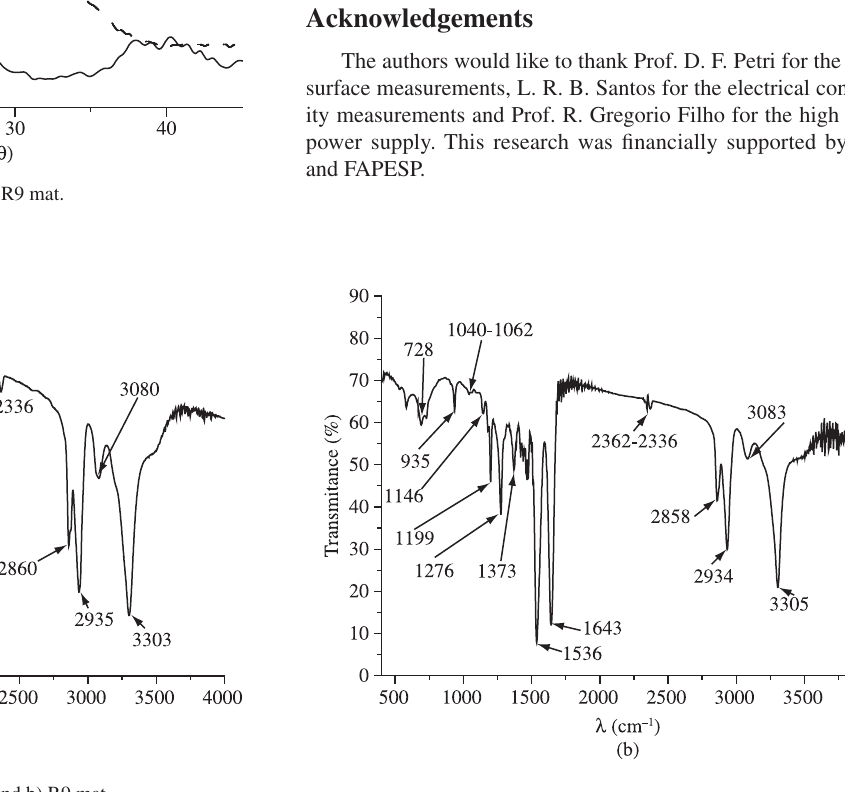
Figure 10. FTIR spectra of: a) sample R; and b) R9